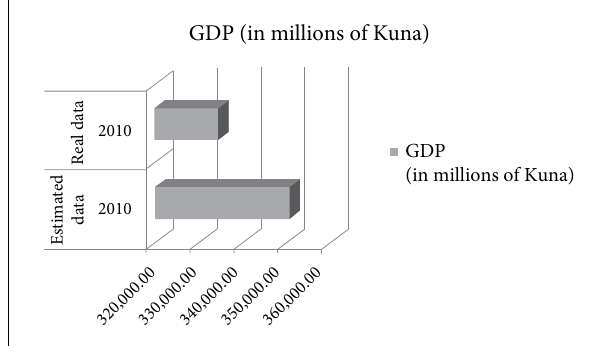
Fig. 5. Comparative review of simulated and actual GDp for 2010 at an exchange rate 1 USD = 5.50 kn. Source: autors calculation GDP (in millions of Kuna)